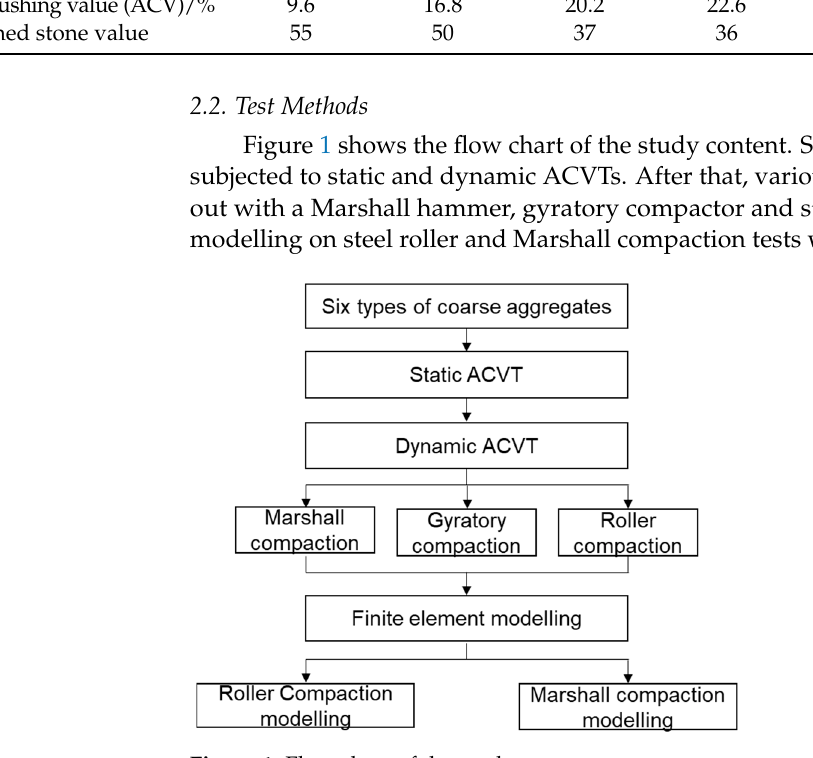
Figure 1. Flow chart of the study content.